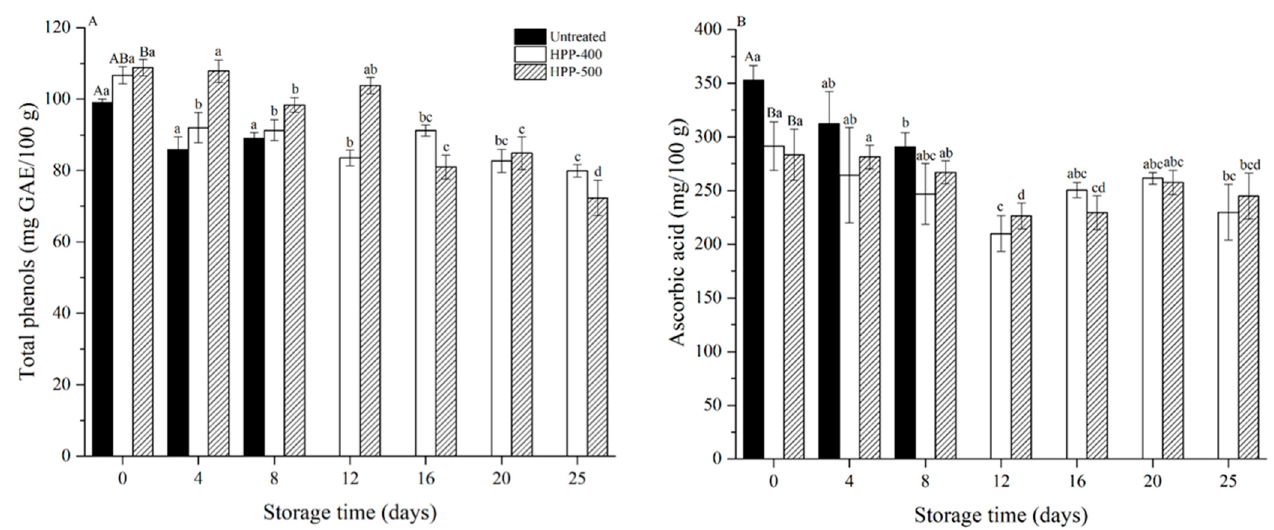
Figure 2. Changes in total phenols ( A ) and ascorbic acid contents ( B ) of fresh-cut bell pepper during storage at 4 °C. The capital letters within one column indicated significant differences at day 0 ( p < 0.05). Values with different letters within one column are significantly different during storage ( p < 0.05).